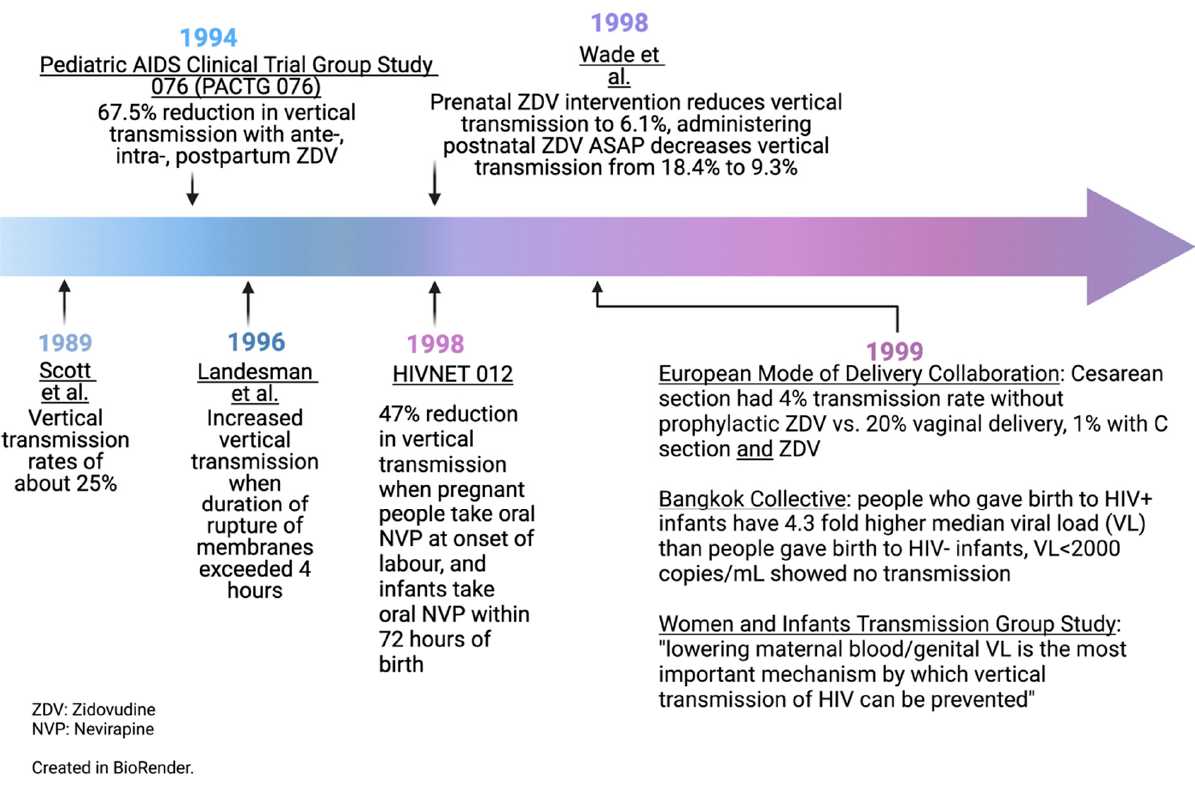
Figure 4. Historical studies in the prevention of vertical transmission of HIV, 1989–1999. Created in BioRender.com.